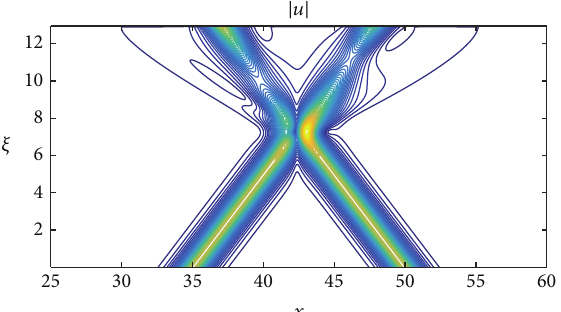
Figure 17: Contour plot of the collision of solitons in Figure 15.